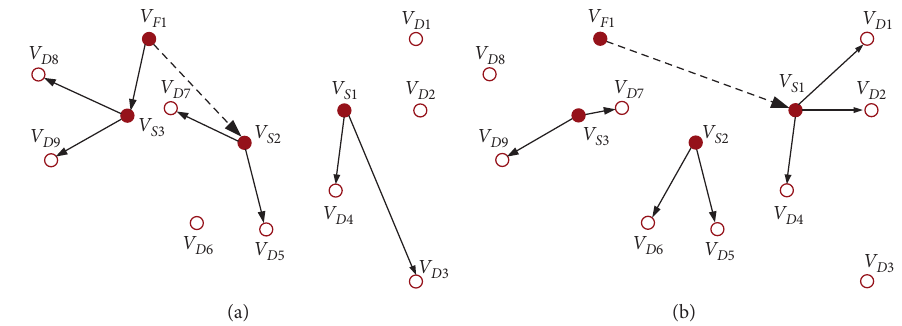
Figure 2: The structure evolution diagram of the military logistic supply chain network. (a) Time t . (b) Time t + n .